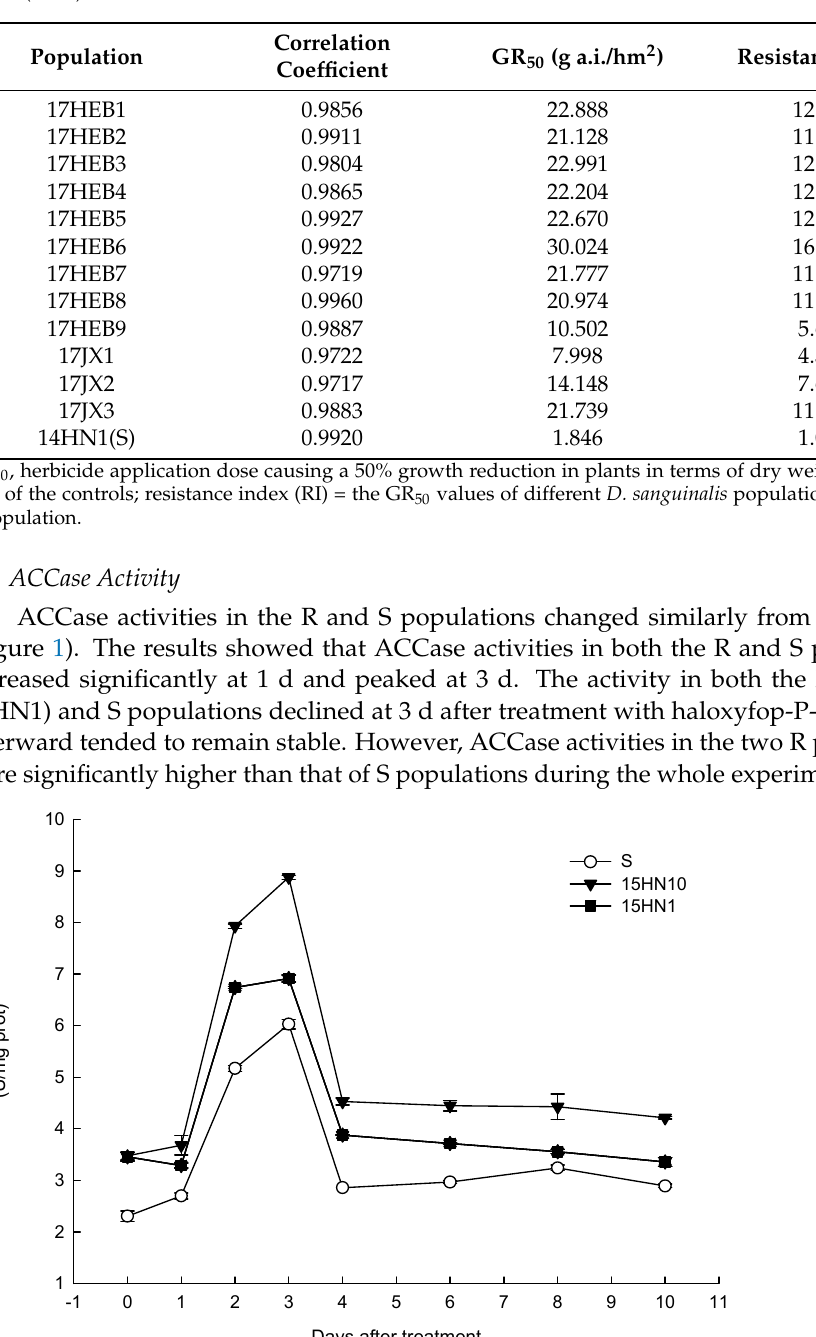
Table 4. The different resistance levels of D. sanguinalis populations to haloxyfop-P-methyl in cotton fields (2017).